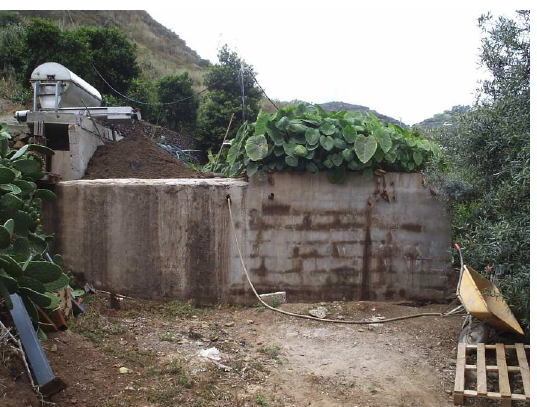
Figure 6. Photograph of Plant 2, with a detail of the rotary screen, and the anaerobic